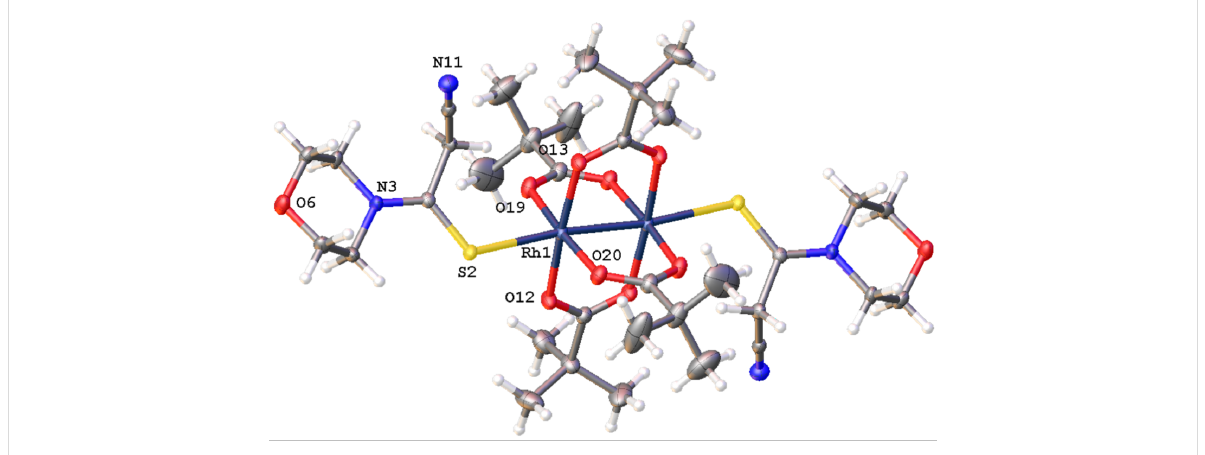
Figure 4: The structure of the complex 6e according to the data of X-ray analysis (Olex2 plot with 50% probability level of ellipsoids).